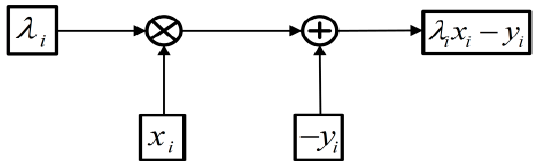
Figure 6. Block-diagram model of utility objective function.